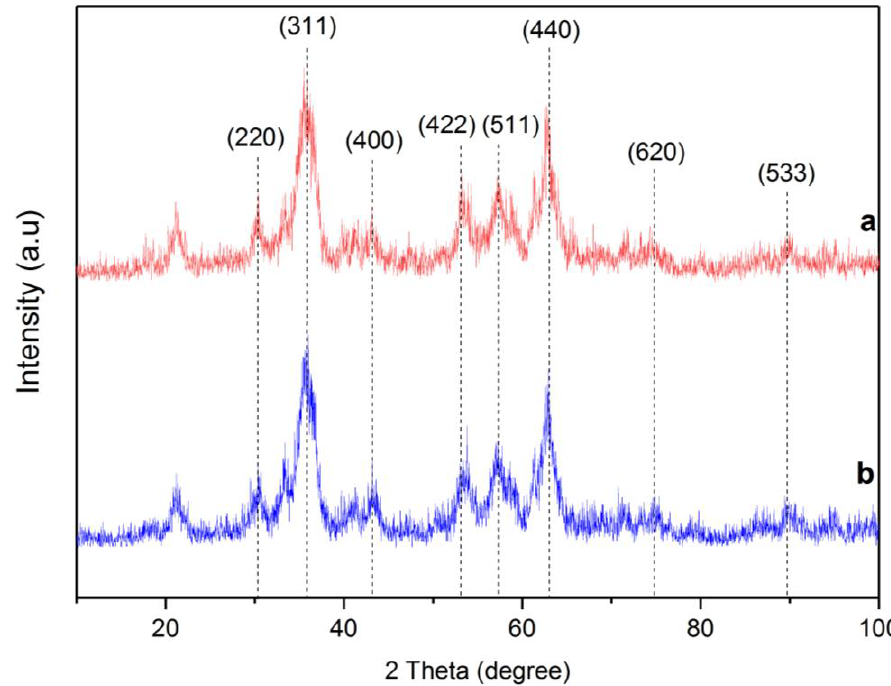
Figure 3. XRD pattern of RMNPs (a) and DextCHO-RMNPs (b).